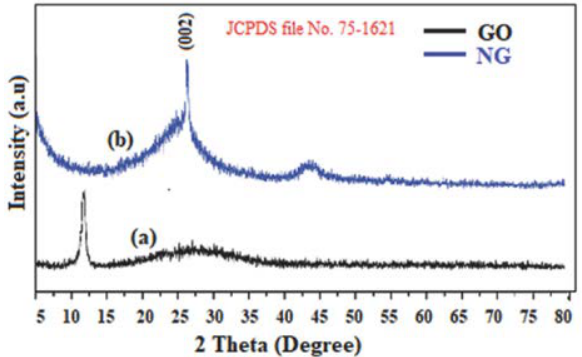
Figure 1. PXRD patterns of (a) GO (b) NG